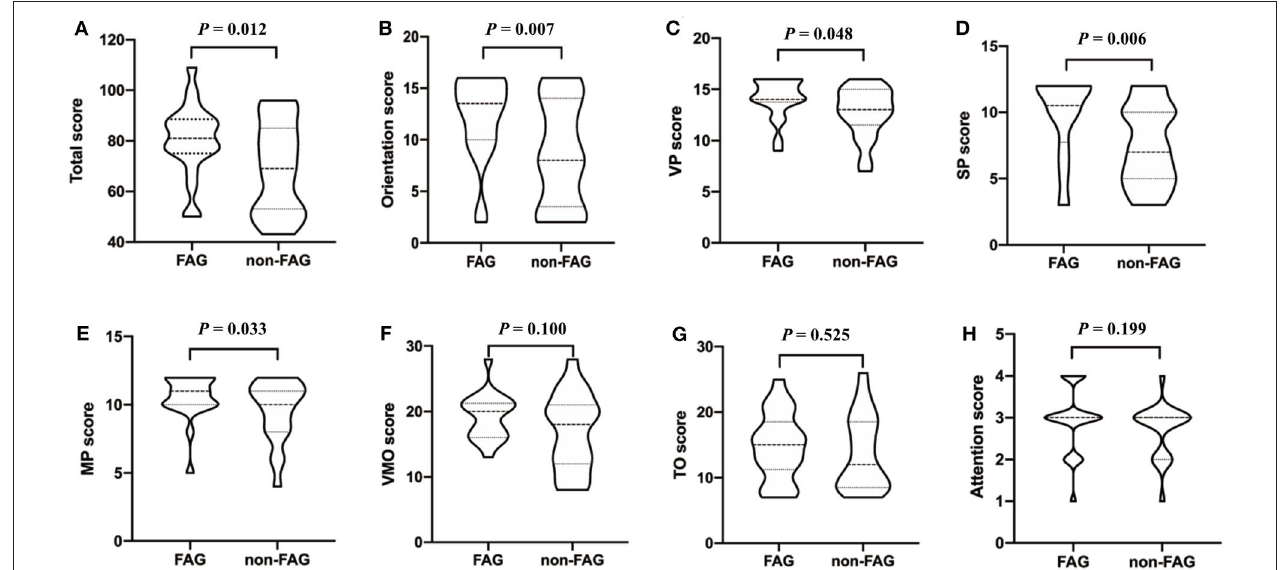
FIGURE 1 | The covariance analysis of LOTCA scores between FAG group and non-FAG group. FAG, fluent aphasia group; VP, visual perception; SP, spatial perception; MP, motor praxis; VMO, visuomotor organization; TO, thinking operations; LOTCA, Loewenstein Occupational Therapy Cognitive Assessment.